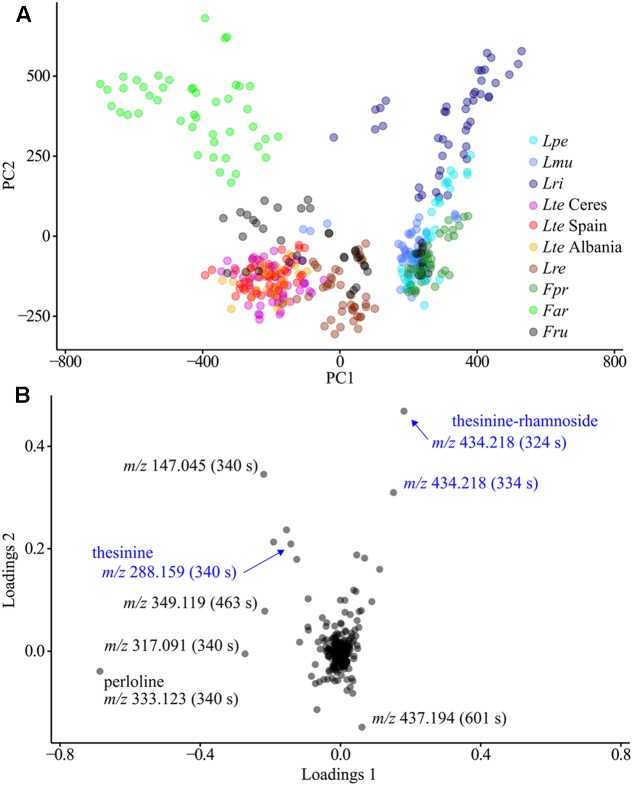
Principal component analysis of all plant extract LC-MS analyses. (A) Scores plot, coloring according to species. (B) Loadings plot with notable compounds marked. QC samples measurements, outliers and buckets representing internal standards are excluded. Lpe – L. perenne (Fennema), Lmu – L. multiflorum (Lema), Lri – L. rigidum, Lte – L. temulentum, Lre – L. remotum, Fpr – F. pratensis, Far – F. arundinacea, Fru – F. rubra.